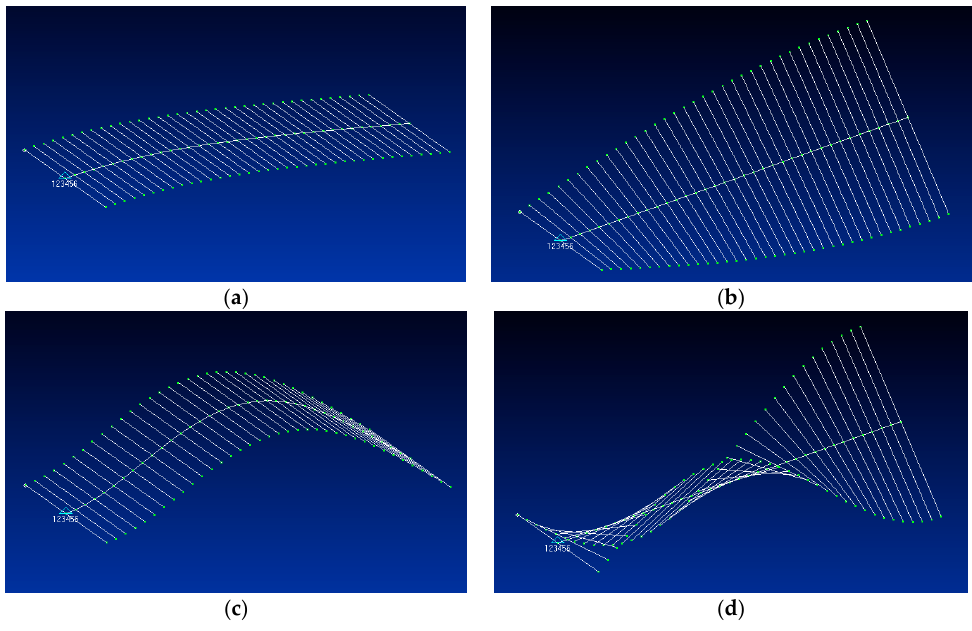
Figure 3. First ( a ), second ( b ), third ( c ) and fourth ( d ) FEM vibration modes, for the wings with AR = 6.